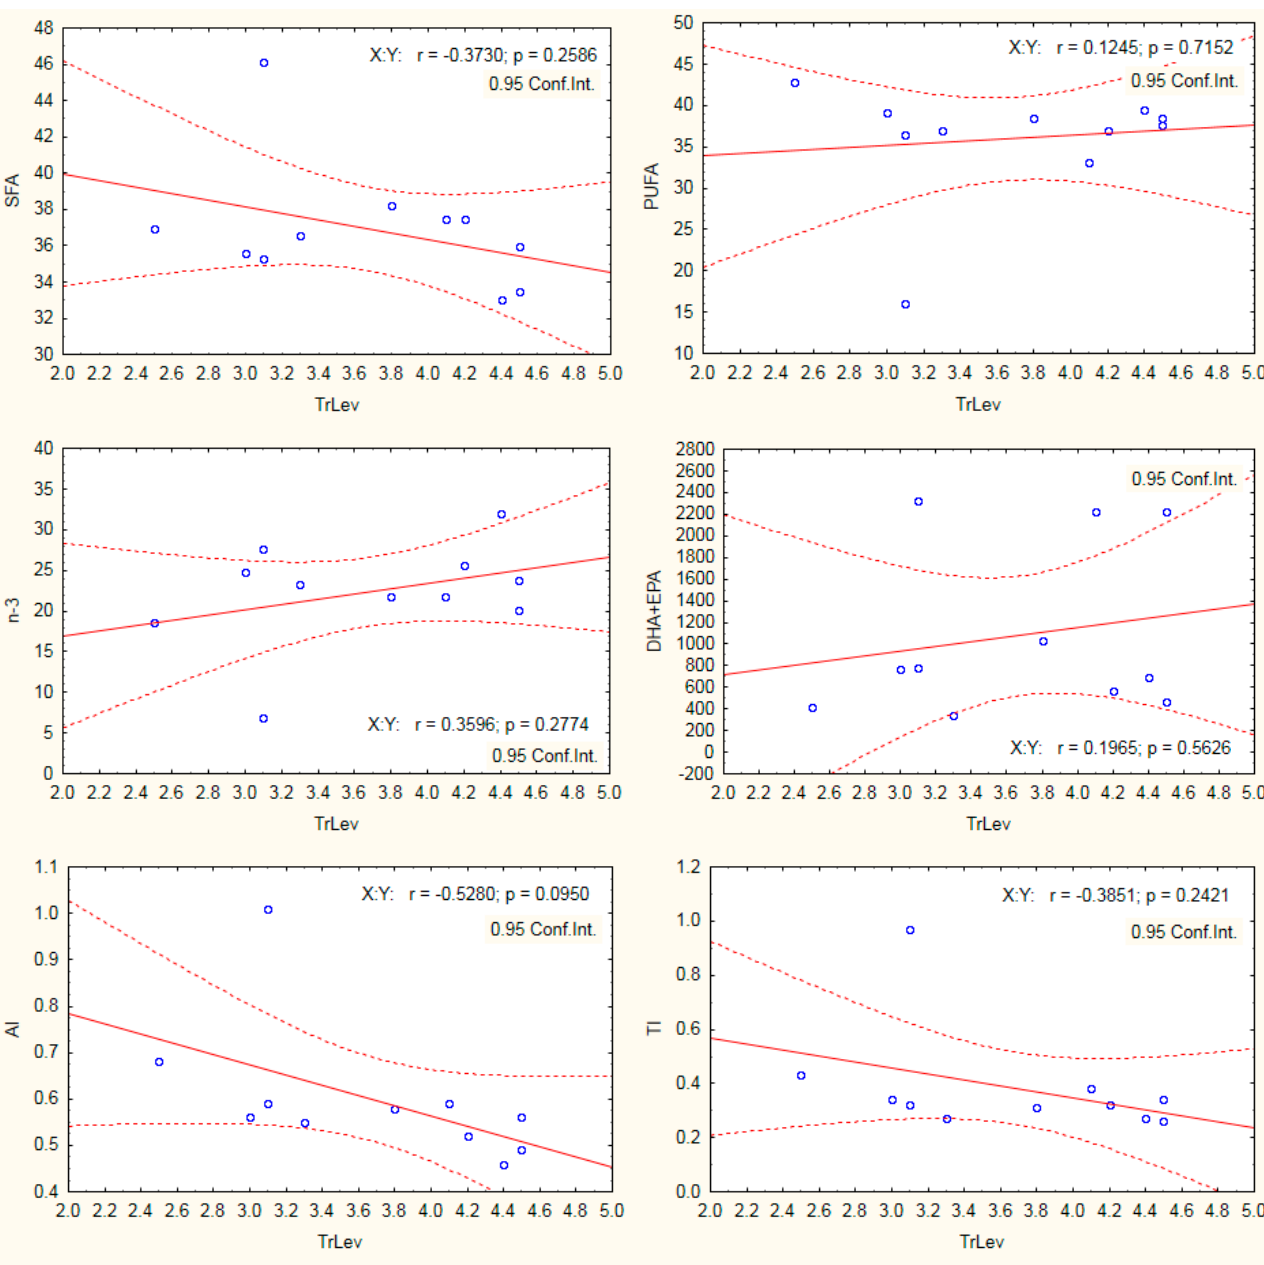
Figure 2. Pearson correlation between trophic levels (TrLev) and fatty acid groups and nutritional quality indices.